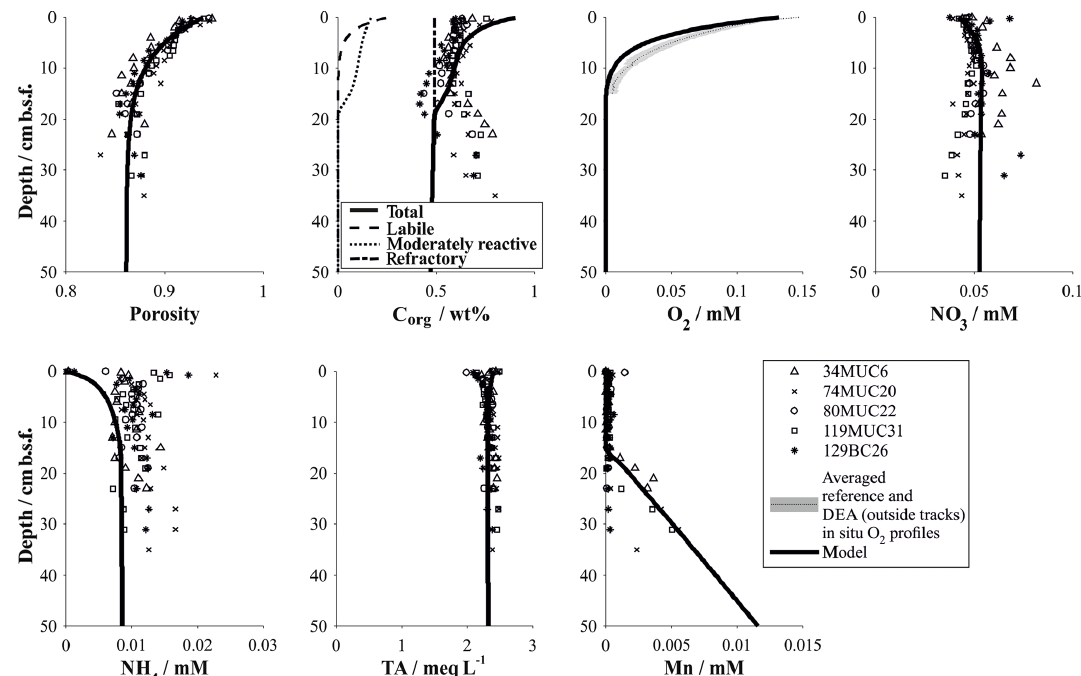
Figure 8. Simulation of background biogeochemical processes and their effect on solute profiles in the DEA region. In addition to the three reference stations, two other undisturbed sites were included for comparison. See Table 4 for parameterization of the modelled profiles.